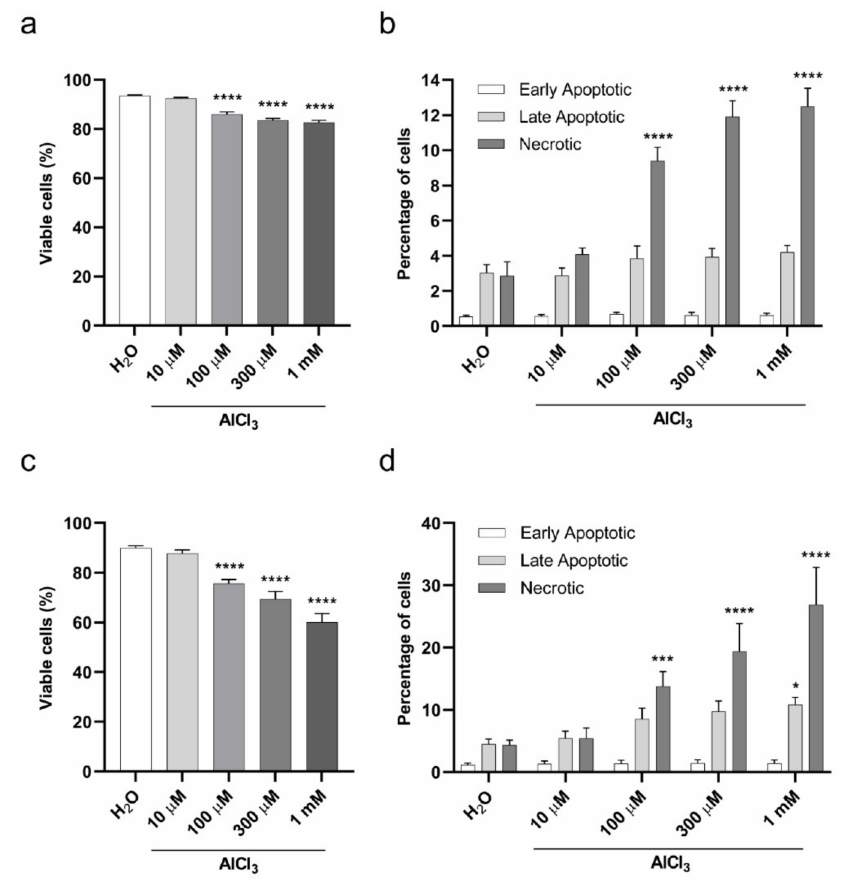
Figure 3. Viability of V79 cells exposed to aluminum by Annexin-V/Propidium Iodide (PI) assay. ( a ) Viability of V79 cells upon 3 h of AlCl 3 exposure in serum-free medium followed by 17 h of recovery in normal culture medium (without AlCl 3 addition). Bars represent the mean ± SEM of three independent experiments (H 2 O 93.58 ± 0.28%; AlCl 3 10 µ M 92.48 ± 0.41%; AlCl 3 100 µ M 86.07 ± 0.87%; AlCl 3 300 µ M 83.53 ± 0.76%; AlCl 3 1 mM 82.68 ± 0.84%). (****) p -value < 0.0001; (Two-way ANOVA with Dunnett’s correction). ( b ) Percentages of early apoptotic, late apoptotic and necrotic V79 cells in the experiment shown in ( a ). Bars represent the mean ± SEM of three independent experiments. (****) p -value < 0.0001; (Two-way ANOVA with Dunnett’s correction). ( c ) Viability of V79 cells upon 24 h of AlCl 3 exposure (1 h in serum-free medium followed by 23 h with 1% FCS addition without medium change). Bars represent the mean ± SEM of four independent experiments (H 2 O 89.97 ± 0.94%; AlCl 3 10 µ M 87.82 ± 1.4%; AlCl 3 100 µ M 75.63 ± 1.65%; AlCl 3 300 µ M 69.47 ± 2.97%; AlCl 3 1 mM 60 ± 3.56%). (****) p -value < 0.0001; (Two-way ANOVA with Dunnett’s correction). ( d ) Percentages of early apoptotic, late apoptotic and necrotic V79 cells in the experiment shown in ( c ). Bars represent the mean ± SEM of four independent experiments. (*) p -value < 0.05; (***) p -value < 0.001; (****) p -value < 0.0001 (Two-way ANOVA with Dunnett’s